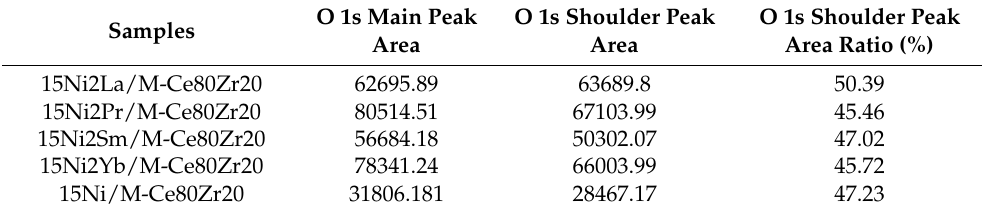
Table 3. O 1s peak areas of the catalysts based on